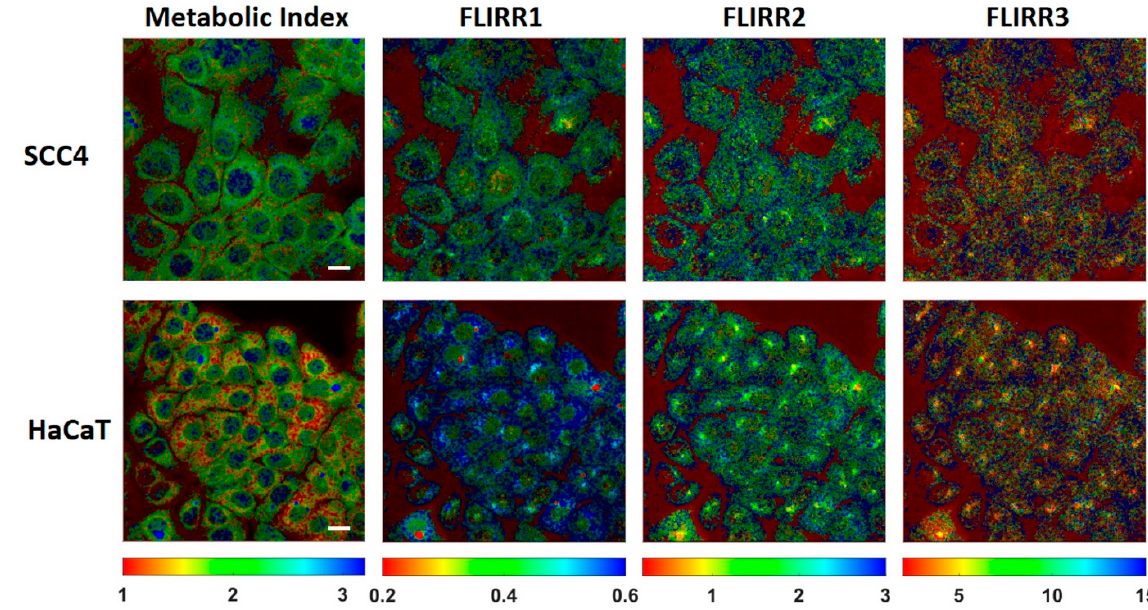
Figure 3. Images of the intracellular distribution of the metabolic NAD(P)H index and FLIRR1, FLIRR2, FLIRR3 indices within HaCaT and SCC4 cells. Scale bar 20 µm.